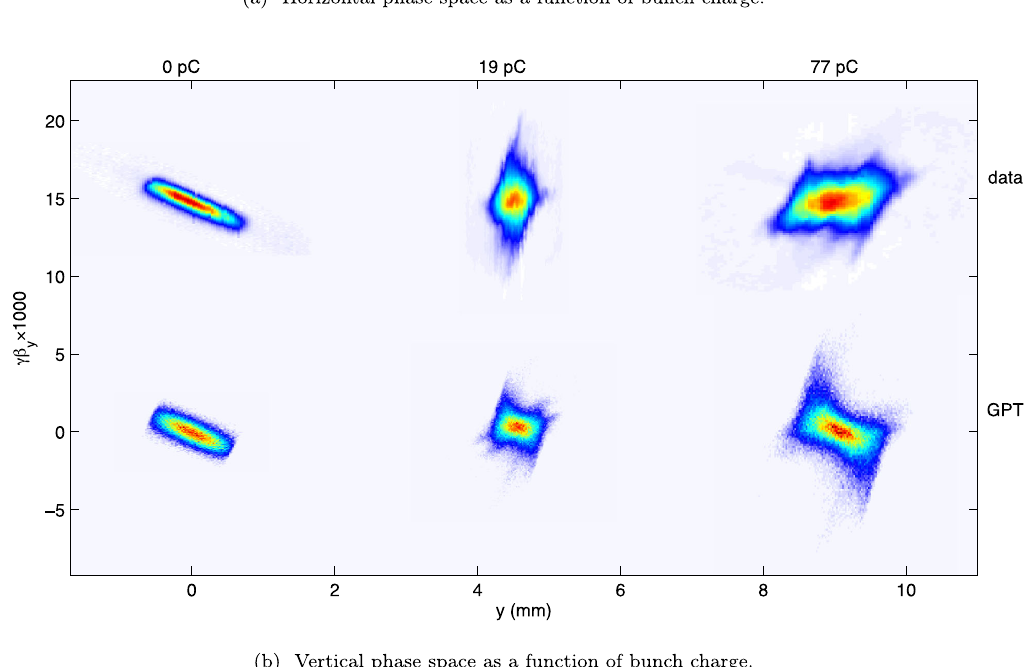
FIG. 15. Comparison of the measured and simulated projected transverse phase space as a function of bunch charge. Plot (a) shows the horizontal phase space, while (b) shows the vertical phase space. Corresponding emittance values can be found in Table